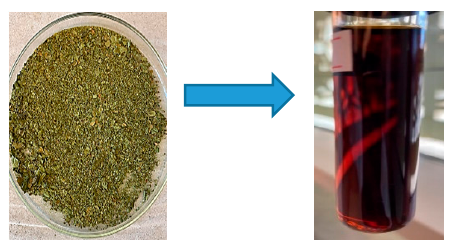
Figure 1. Convolvulus arvensis leaf extract.